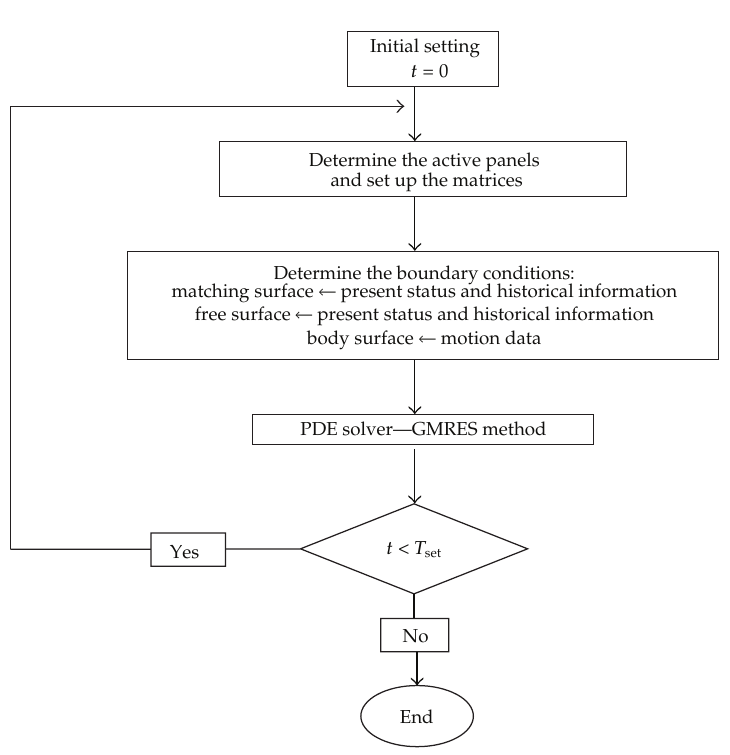
Figure 2: Flowchart of the HYBRID method program, with forward